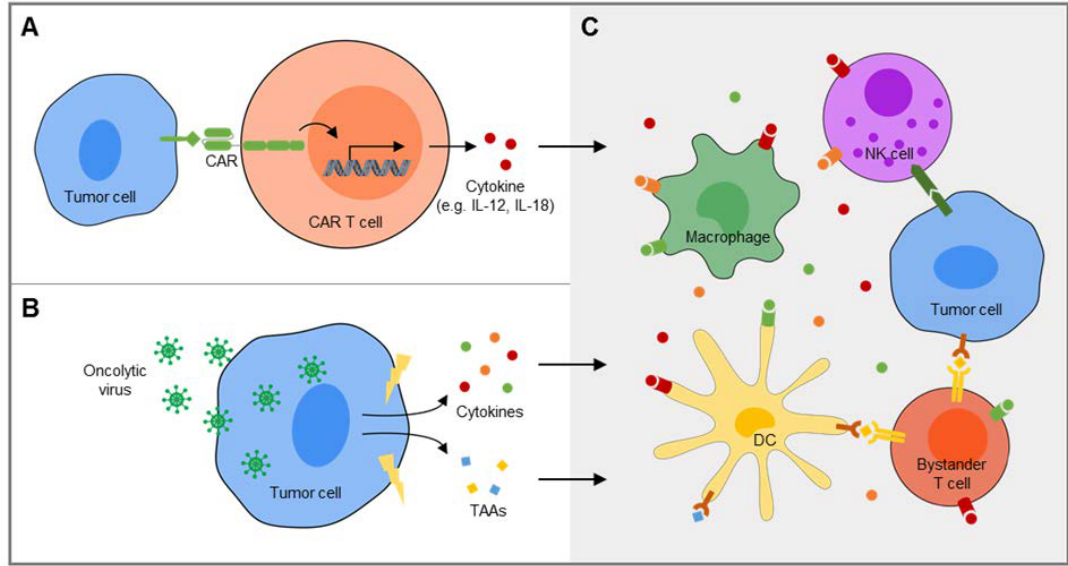
Figure 3. Recruitment and activation of bystander cells for amplification of CAR T cell-induced immune responses. ( A ) CAR T cells can be engineered to secrete a specific